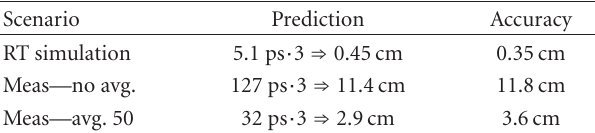
Table 3: Predicted and calculated accuracy for scenarios in E1. Scenario